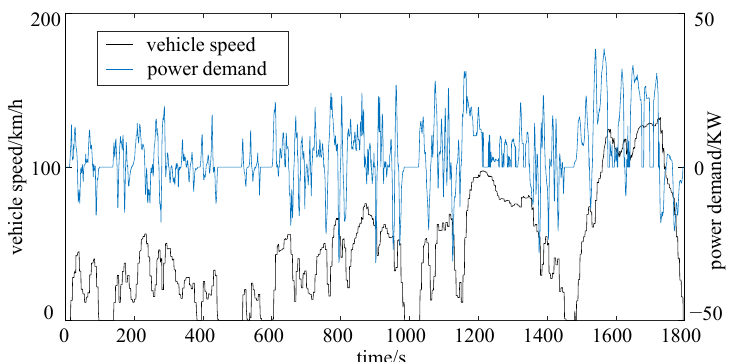
Figure 20. Vehicle speed and power demand of WLTC cycle.